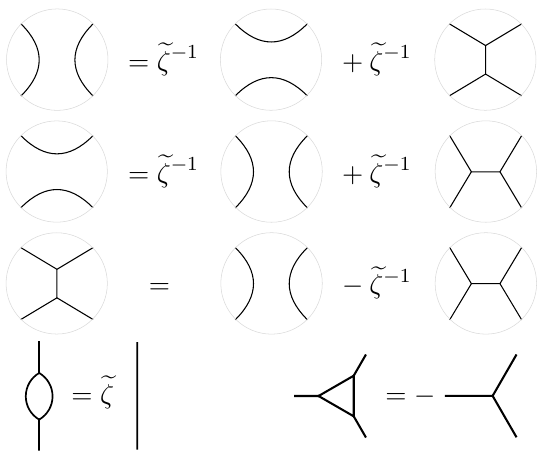
Figure 36 . Some useful crossing relations involving W